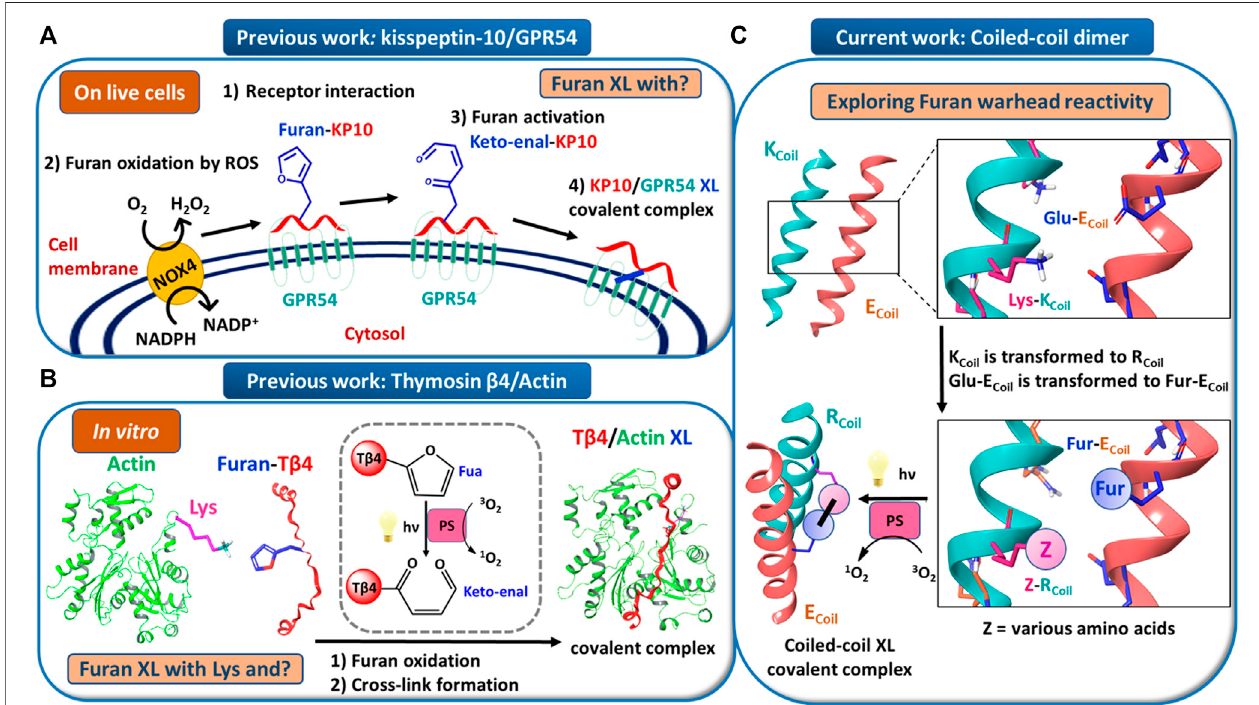
FIGURE 1 | (A) Model for endogenous furan oxidation by reactive oxygen species (ROS). The mature glycosylated GPR54 receptor is present at the cell surface. When the furan-modi fi ed kisspeptin-10 peptide (Furan-KP10) is added, it interacts at the cell surface with GPR54 (step 1). Due to the presence of an NADPH oxidase (likely NOX4), present in the plasma membrane, ROS are locally released in the extracellular environment. Then, the Furan-KP10 is oxidized by ROS (step 2) to a keto- enal-KP10(step 3)and forms acovalent cross-link withthe receptor (step 4). (B) Model for in vitro furan oxidationby singlet oxygen production. Actin and Fua-T β 4 were fi rst pre-incubated. Then, the furan moiety was activated by oxidation followed by cross-link formation. The oxidation relies on singlet oxygen generation by visible light irradiation in the presence of a photosensitizer (PS), such as Rose Bengal or Rhodamine B. (C) Model system to explore furan warhead reactivity towards different amino acid side chains in a coiled-coil peptide